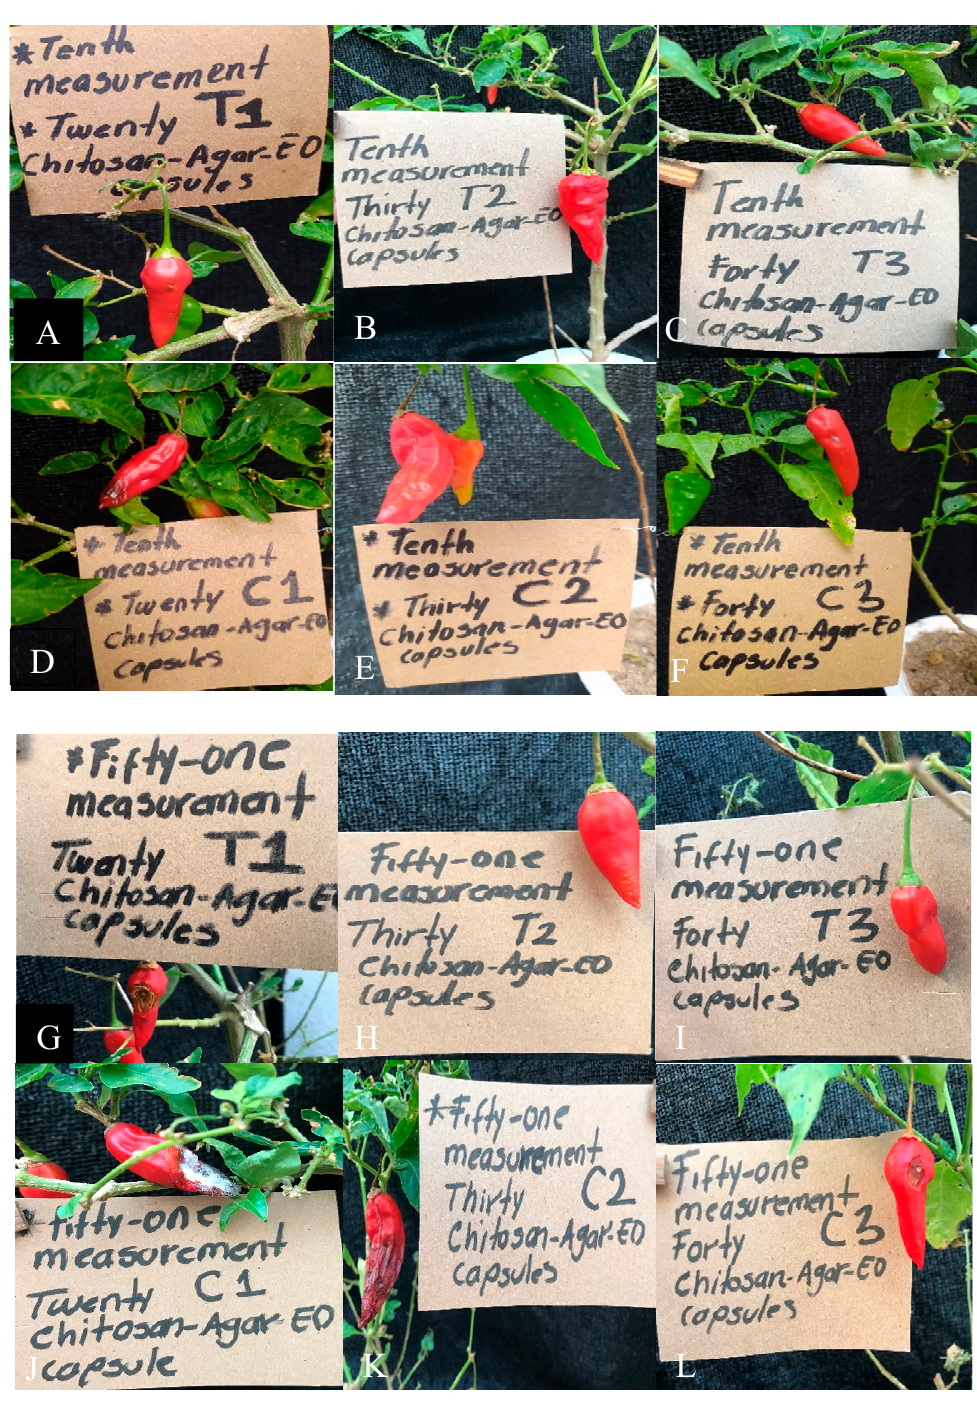
Figure 8. Damage assessment of Topito peppers at different durations. Day 10 ( A – F ) and 51 ( G – L ) of evaluation: peppers and leaves with slight signs of infection in treatment with 20 capsules of EO and without signs of infection in treatments with 30 and 40 capsules of EO. Peppers and leaves with serious signs of infection in controls with 20, 30, and 40 capsules of corn oil.